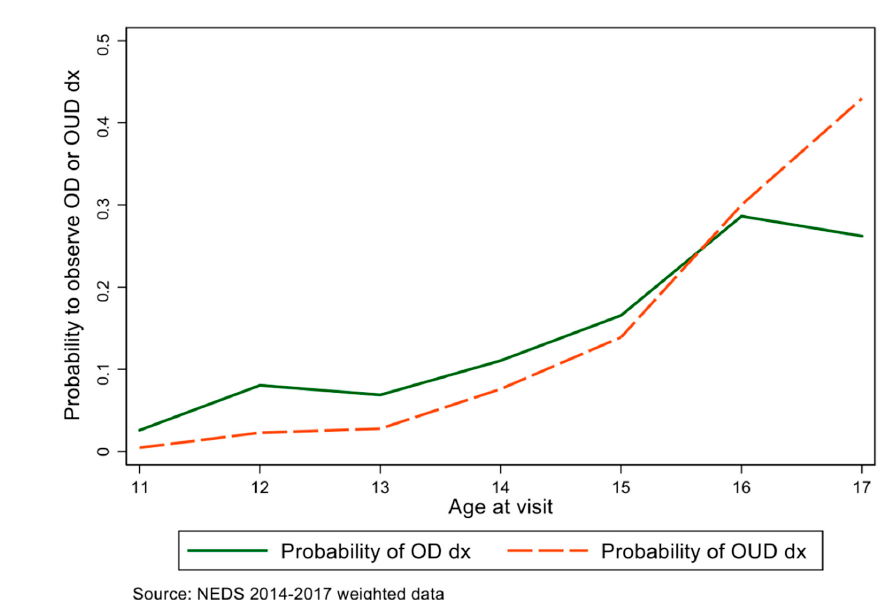
Figure 2. Increasing probability of an opioid-related visit, age 11–17. Source: NEDS 2014–2017, weighted data. OD, overdose; OUD, opioid use disorder; dx, diagnosis.